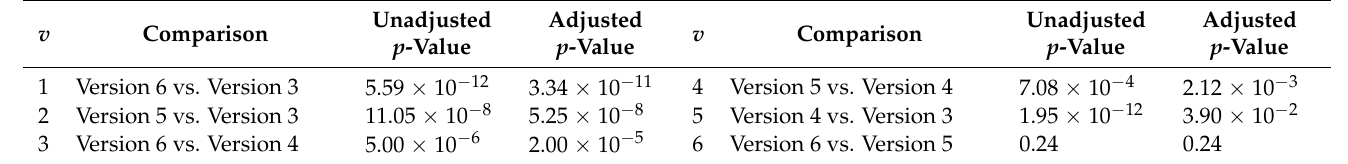
Table 9. The unadjusted and adjusted p -values for multiple comparisons among the five